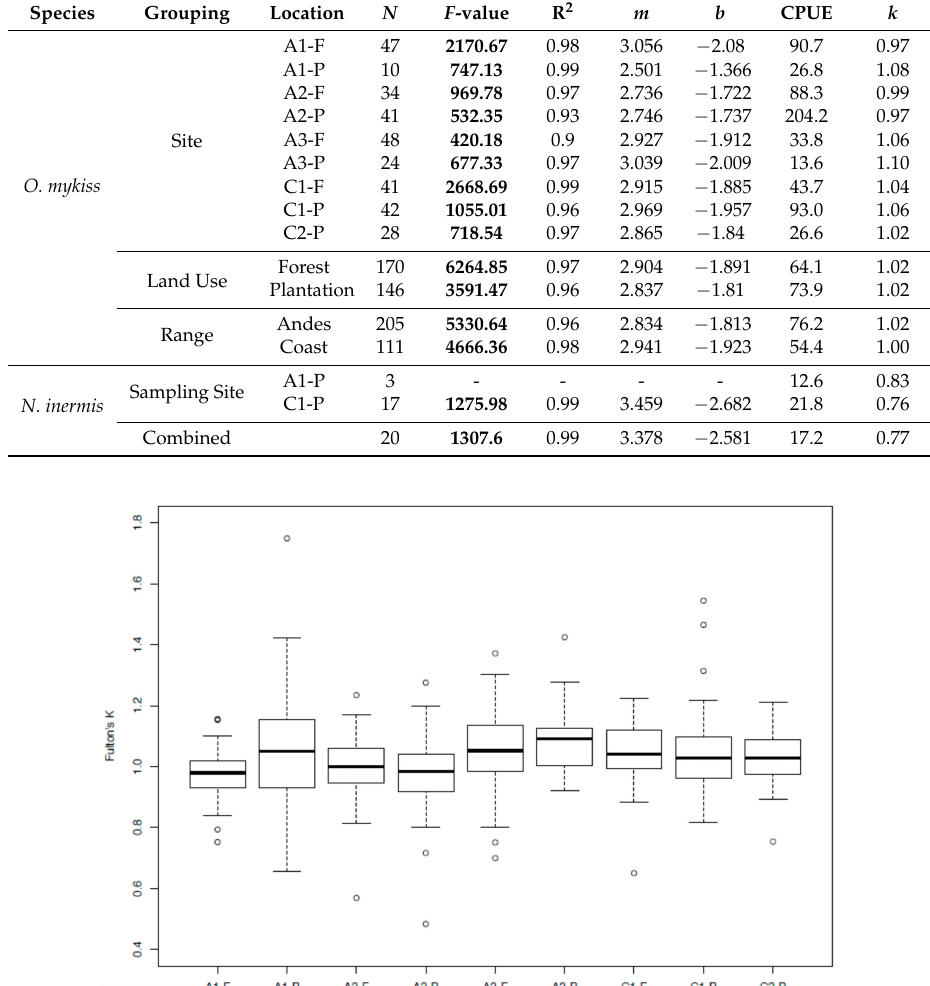
Table 1. Log-transformed length-weight regression relationships ( F : statistic and R 2 : correlation coefficient), standardised abundance (catch per unit effort (CPUE)), and Fulton’s condition factor ( k ) for Oncorhynchus mykiss and Nematogenys inermis , organized by sampling sites, paired catchments, land use types, mountain ranges and mountain range × land use (bold: p < 0.0001), where m is slope and b is intercept. CPUE = number of fish/500 m 2 .